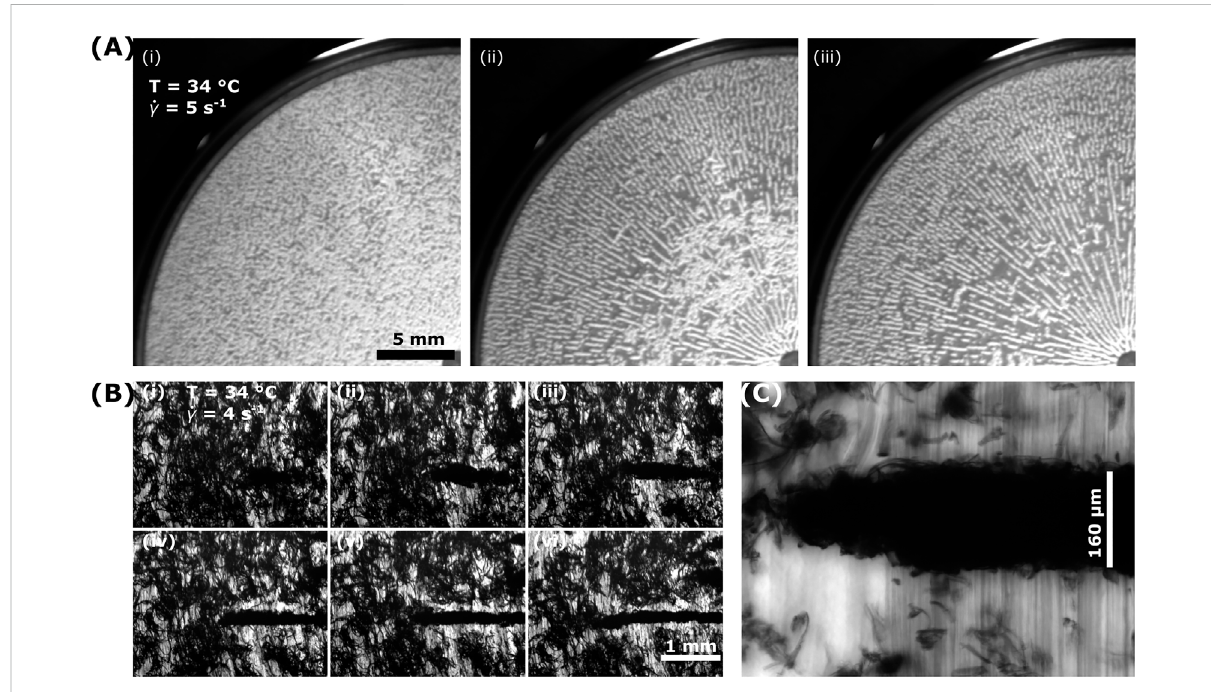
FIGURE 3 Shear-induced vorticity-aligned fl oc formation across scales. (A) Using a macro lens to capture a quarter of the parallel-plate geometry (diameterof40 mm),weobservesampleshavingundergone atemperatureramp to34 ° Cwithaconstantshearrateof _ γ T ↑ (cid:1) 5s − 1 .Imagesareshown after thesamplehas reached 34 ° Cand isbeingshearedat _ γ hold (cid:1) 5s − 1 .The time interval between each imageinthe setofthree (i – iii)is70 s. The fi rst image (left) was taken seconds after the sample reached 34 ° C. While here we observe fl ocs throughout the geometry, we note that in other casesweobserve fl ocsmainlynearthecenterorneartheedgesofthegeometry. (B) Theinitialformationofavorticity-aligned fl ocisobservedusing a 2× objective while the sample is shared at _ γ hold (cid:1) 4s − 1 after reading 34 ° C. The time interval betweeneach image (i – vi)is 11.4 s. Counter-rotating of the bottom glass plate of the parallel-plate geometry was used to keep the fl oc in the fi eld of view. Supplementary Video S1 captures this fl oc formation. (C) Image of a vorticity-aligned fl oc formed at 34 ° C using a shear rate of 4 s − 1 taken with a 10× objective. The width of the fl oc is approximately equal to the parallel-plate gap height (here, h (cid:1) 157 μ